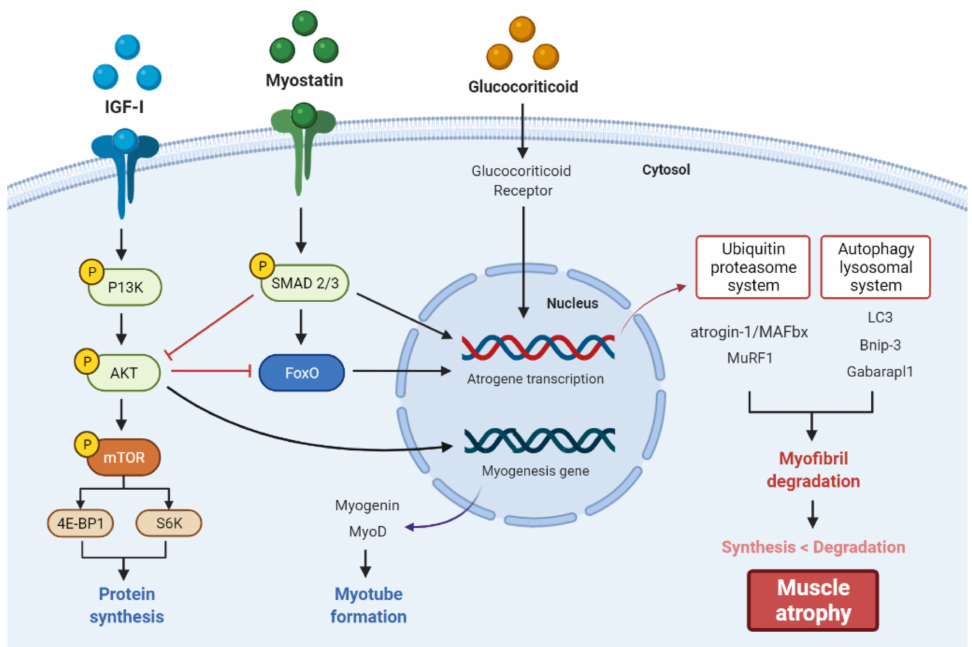
Figure 1. Molecular mechanisms of glucocorticoid-induced muscle atrophy. Glucocorticoid-induced skeletal muscle atrophy is associated with the altered expression of IGF-I and myostatin, two regula- tors that play important roles in skeletal muscle growth and development, resulting in decreased protein synthesis and increased